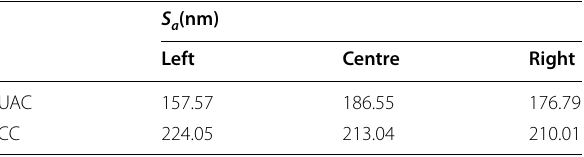
Table 1 Blade roughness values of S ultrasonically assisted and conventional cutting styles